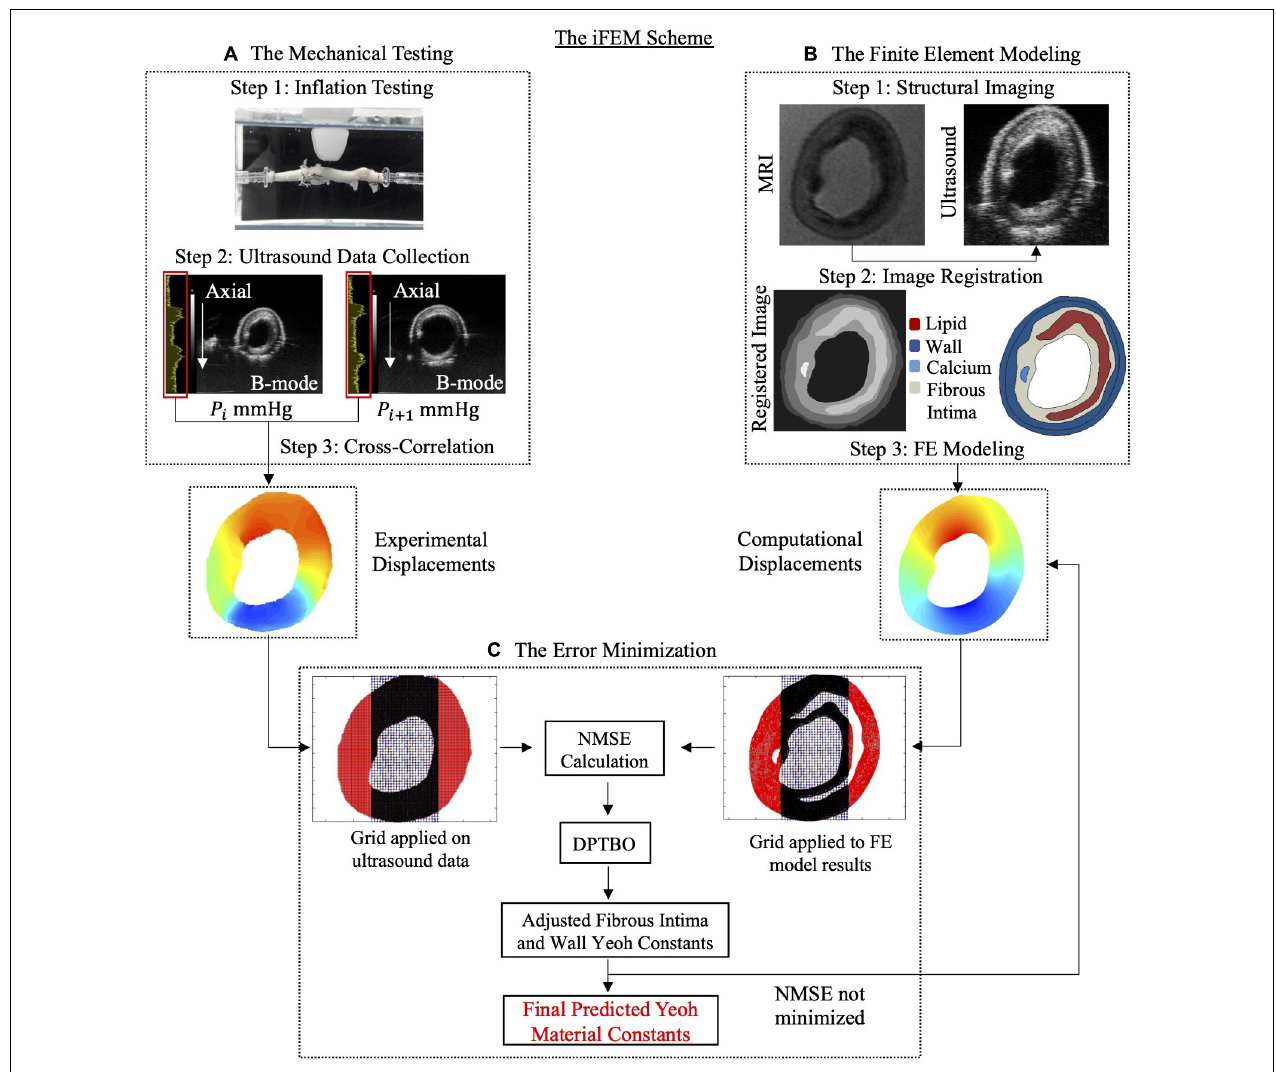
FIGURE 1 | The inverse finite element modeling (iFEM) scheme composed of three main parts: mechanical testing (A) , finite element modeling (B) , and error minimization (C) . DPTBO, deep partitioning tree based Bayesian optimization; FE, finite element; MRI, magnetic resonance imaging; NMSE, normalized mean square error; RF,